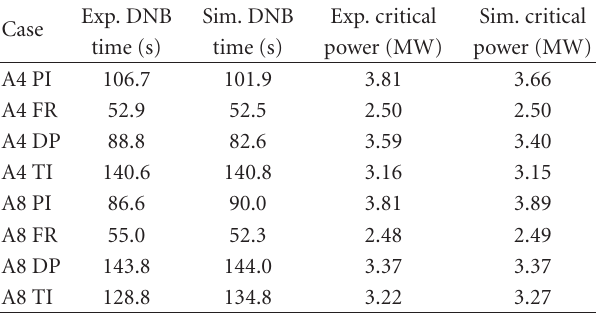
Table 10: Occurrence of critical heat flux conditions in transient